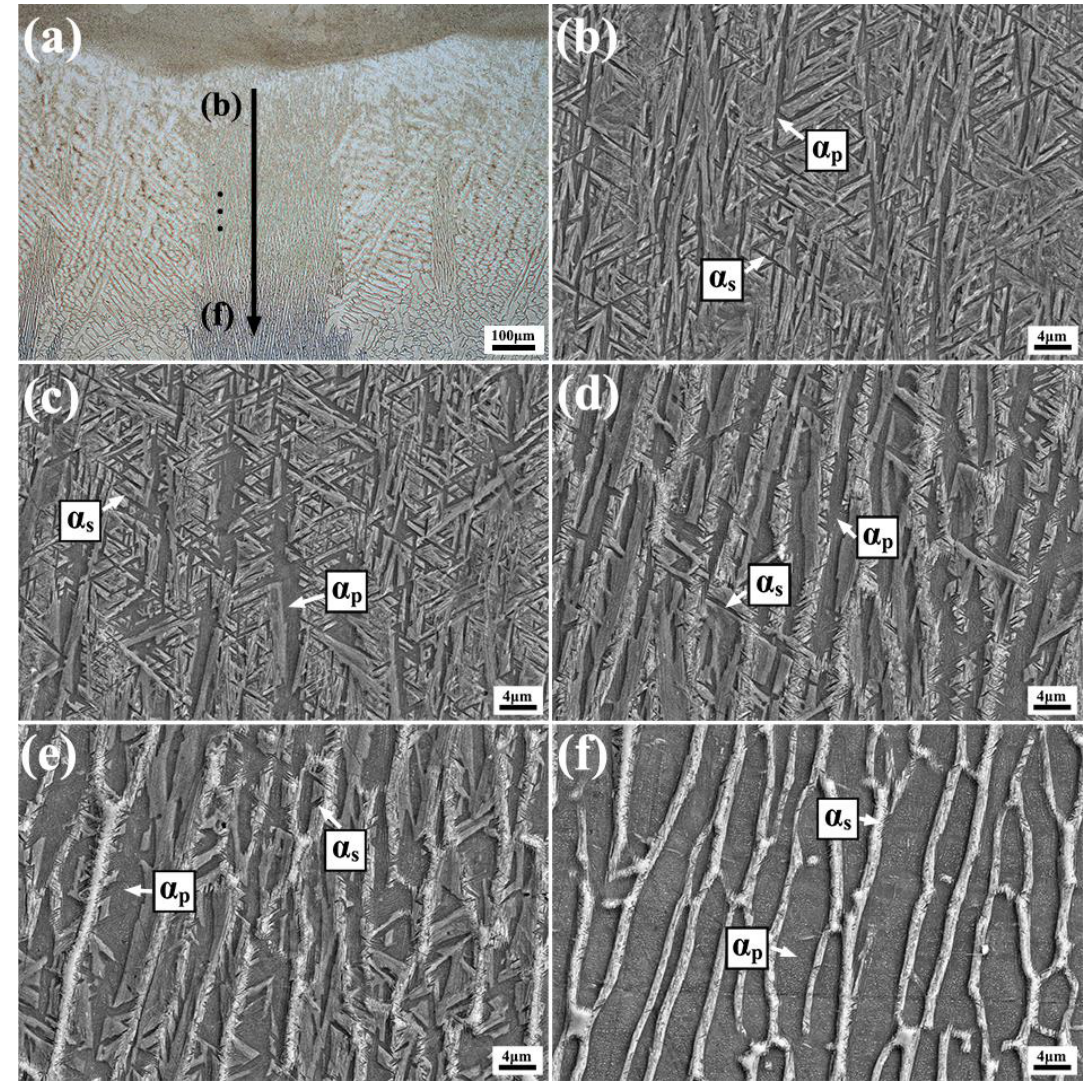
Figure 3. Microstructure in the TZ: ( a ) overview, ( b – f ) the corresponding higher magnification images in ( a ), obtained at 100 µ m intervals,